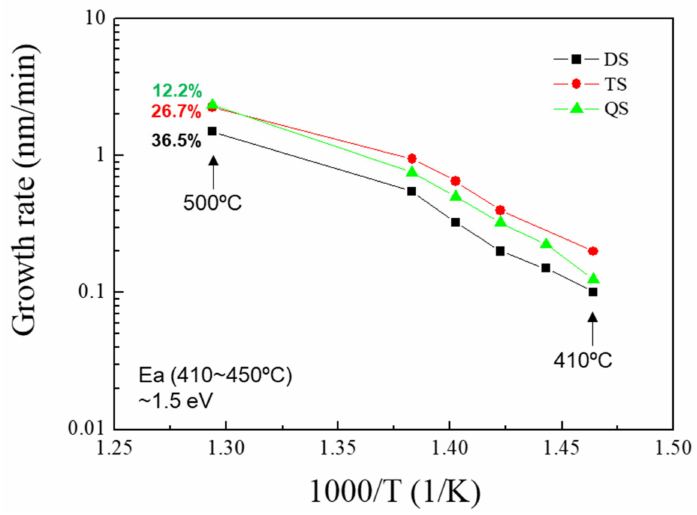
Figure 10. Arrhenius plot of the SiGe epilayers grown using disilane, trisilane, and tetrasilane.